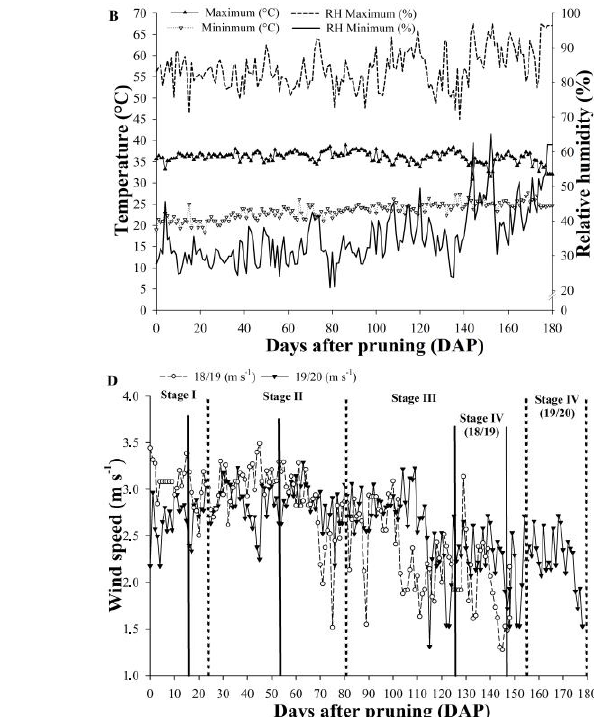
Table 1. Analysis of the organic source used in fertilizing